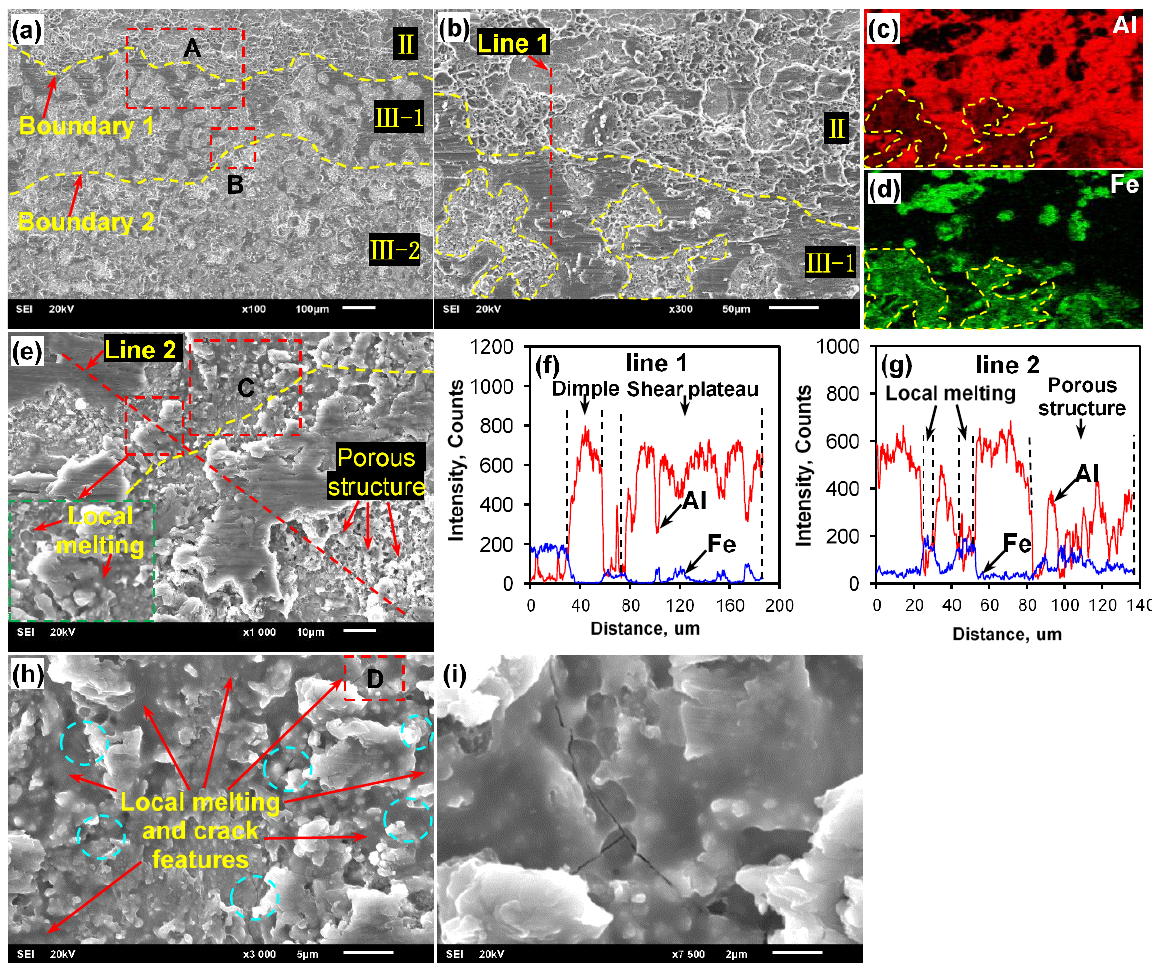
Figure 4. The evolution of shear plateau along with metal debris, pores, local melting, and cracking features in layer III: ( a ) a low magnification SEM image containing layers II, III-1 and III-2; ( b ) magnified image of area ‘A’ in ( a ), showing the large shear plateau with metal debris; ( c , d ) EDS elemental maps of ( b ); ( e ) magnified image of area ‘B’ in ( a ), showing the small shear plateau with local melting and porous features; ( f , g ) EDS line scan results along lines 1 and 2 in ( b ) and ( e ), respectively; ( h ) magnified image of area ‘C’ in ( e ), showing the local melting and cracking features; ( i ) magnified image of area ‘D’ in ( h ), showing the cracking features in the local melting zone.